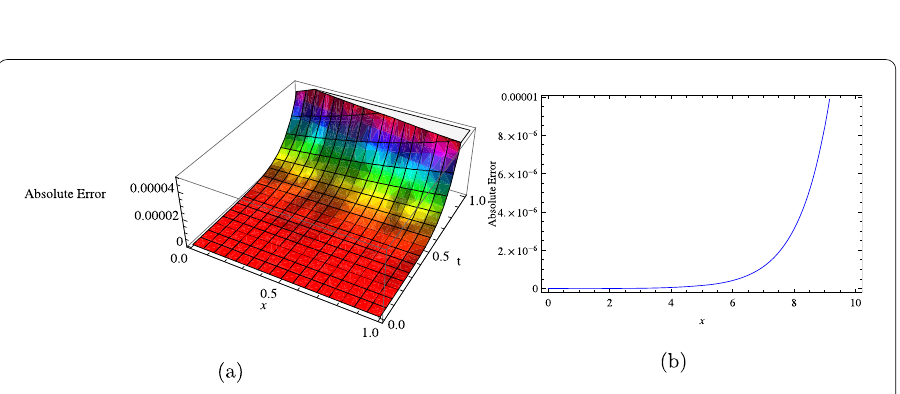
Figure 4 Plot of the absolute error of TFNWS equation when (cid:2) = –1.2. ( a ) E 4 ( η ) = | η ( x , t ) – η 4 ( x , t ) | . ( b ) The corresponding E 4 ( η ) when t =